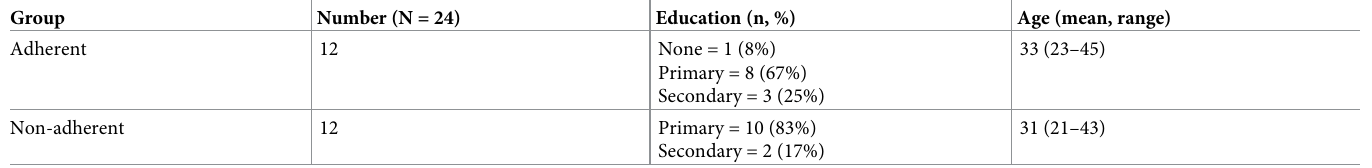
Table 2. Summary of caregivers included in the focus group